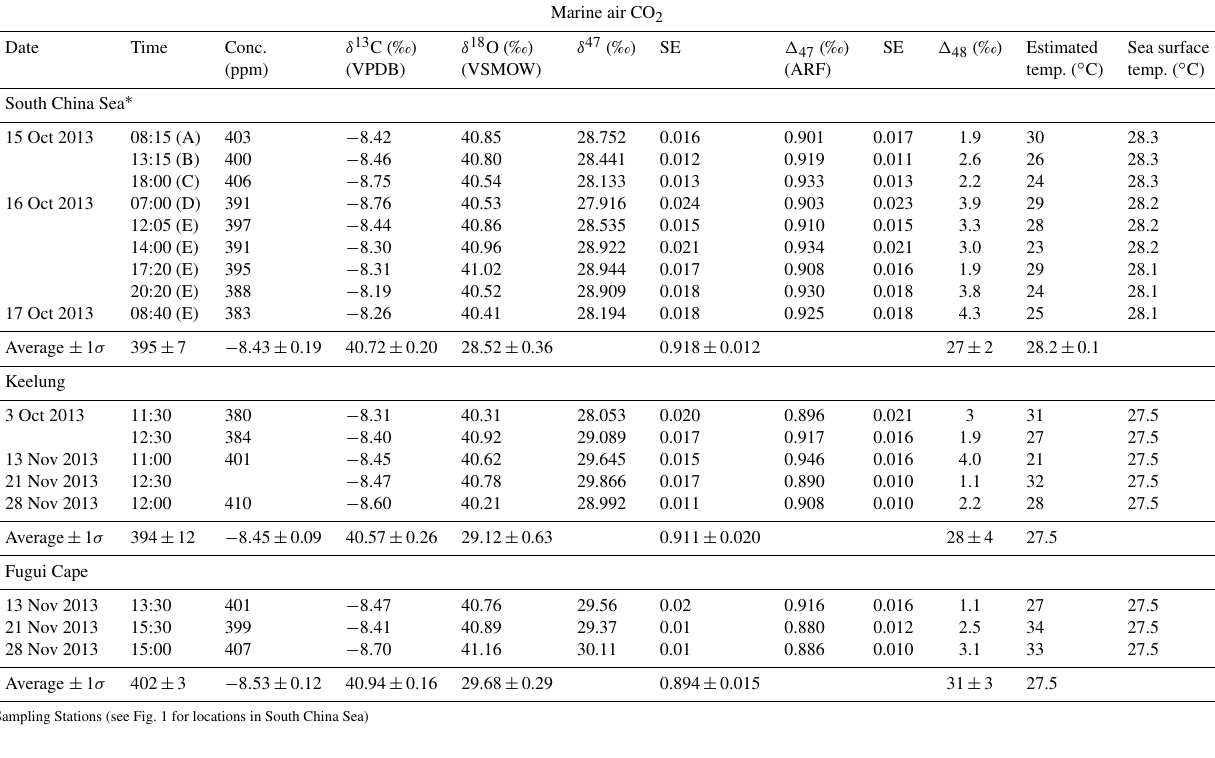
Table 3. Stable isotopic composition including (cid:49) 47 for atmospheric CO 2 collected over South China Sea and two coastal stations (see Fig. 1 for sampling locations). Temperatures estimated using (cid:49) 47 values and the sea surface temperatures at the time of samplings are also presented.